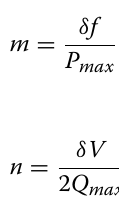
current that may produce over